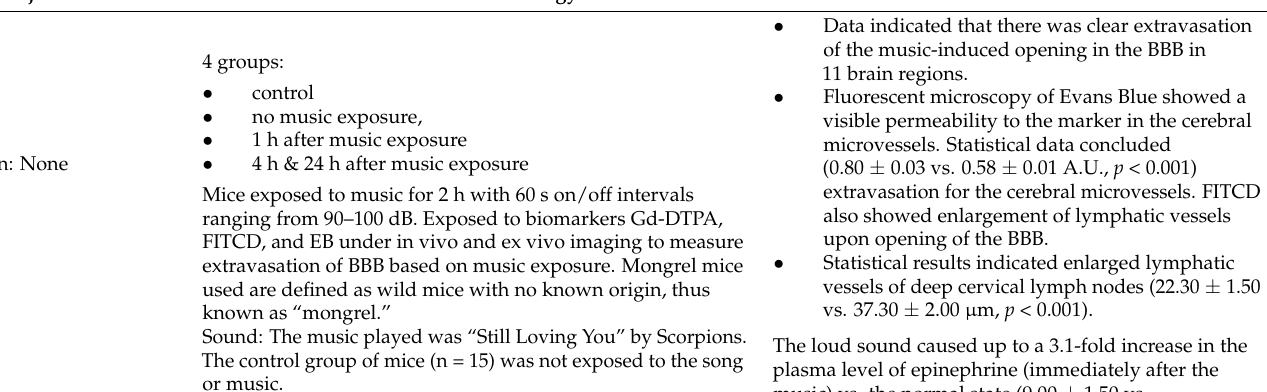
Table 1. Cont. Reference Test Subjects Research Methodology Anatomical/Functional Outcomes